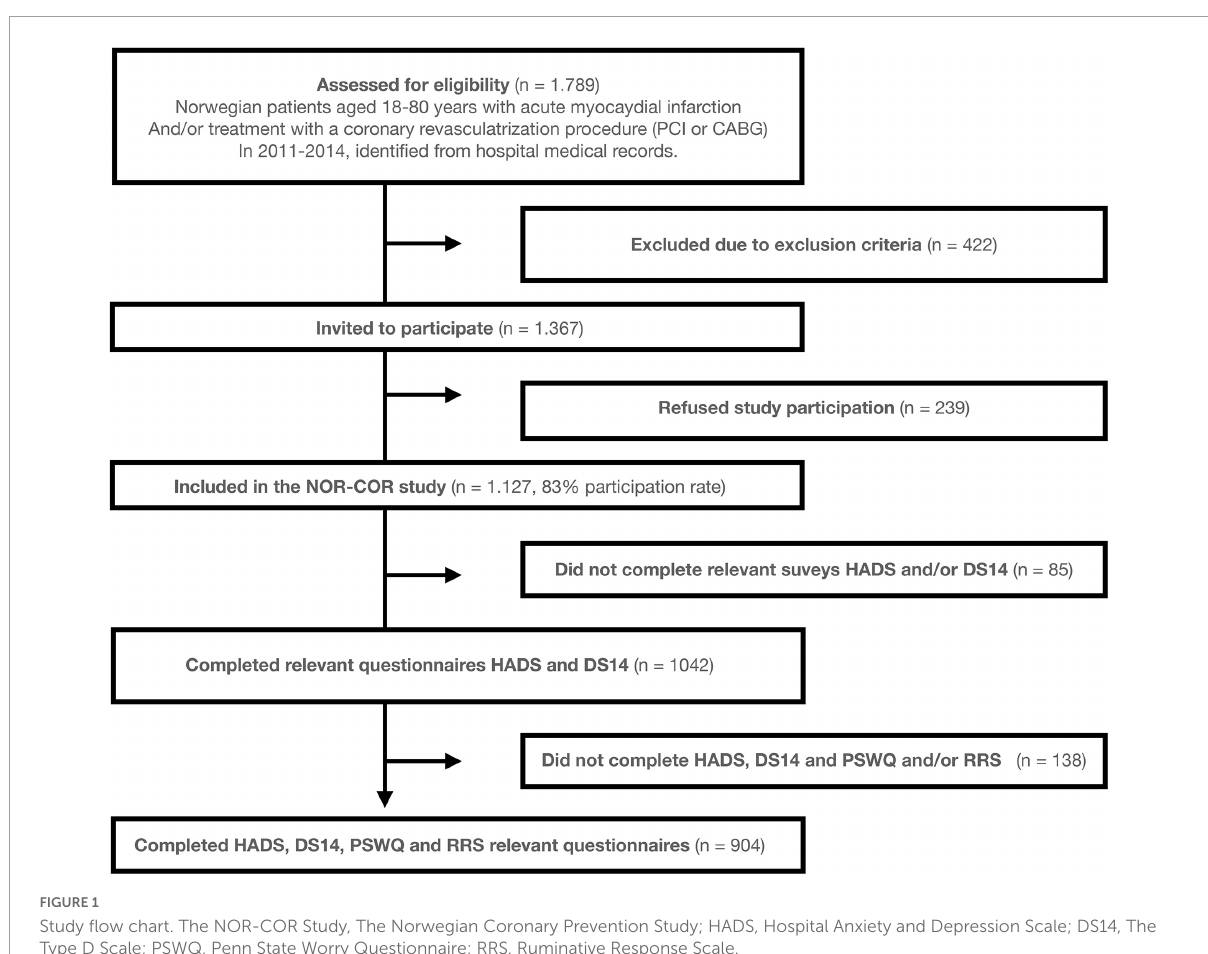
FIGURE1 Study flow chart. The NOR-COR Study, The Norwegian Coronary Prevention Study; HADS, Hospital Anxiety and Depression Scale; DS14, The Type D Scale; PSWQ, Penn State Worry Questionnaire; RRS, Ruminative Response Scale.